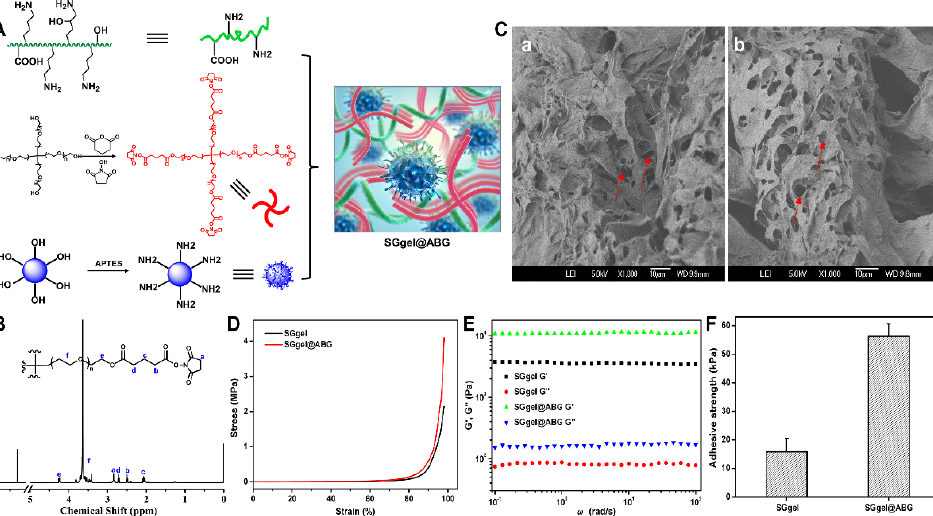
Figure 2. Structure and property characterizations. ( A ) Synthesis route of modified polymers and amine ‐ functionalized ABG. ( B ) 1 H NMR spectrum of the tetra ‐ PEG ‐ SG polymer. ( C – F ) SEM images, compressive, rheology and adhesive profiles of ( a ) SGgel and ( b ) SGgel@ABG hydrogels. Red arrows represent the similar inner pores.